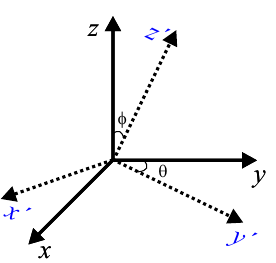
Figure 3. Cartesian coordinates (continuous line), steered coordinates (dotted line) and the angles θ and φ .